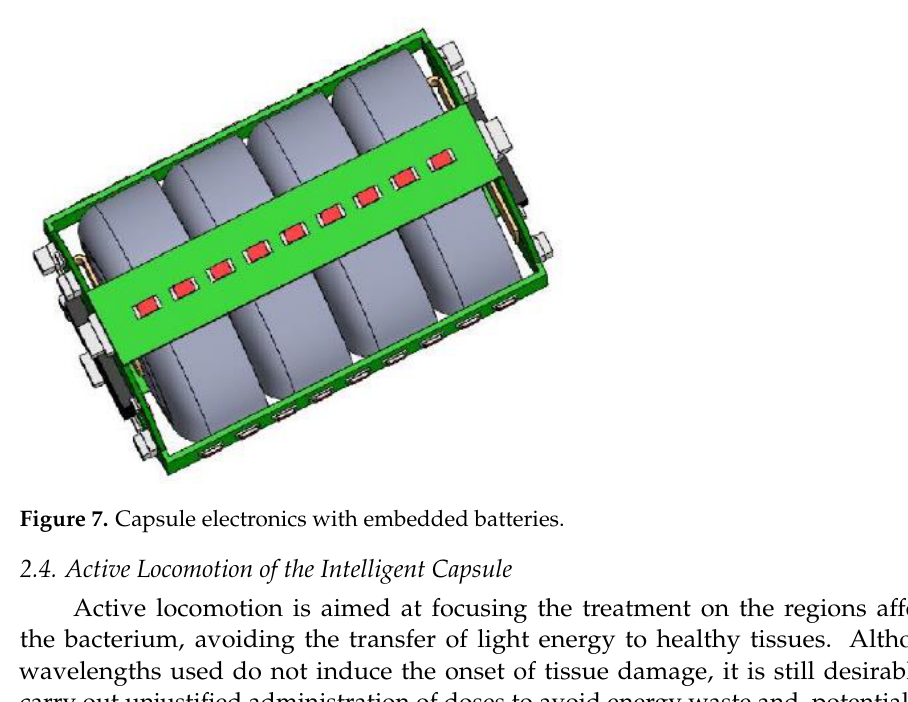
Figure 6. Capsule electronic board design.